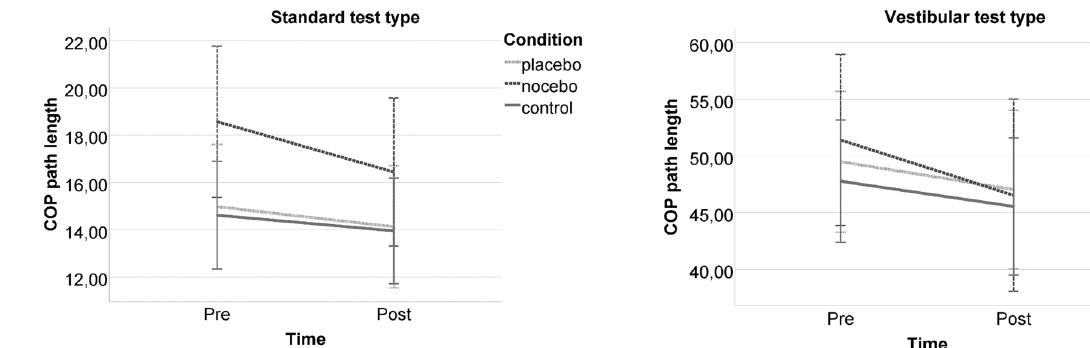
Fig. 5 Postural stability performance of the experimental groups pre- and post-intervention in the vestibular test type. Note: The error bars reflect 95% CI